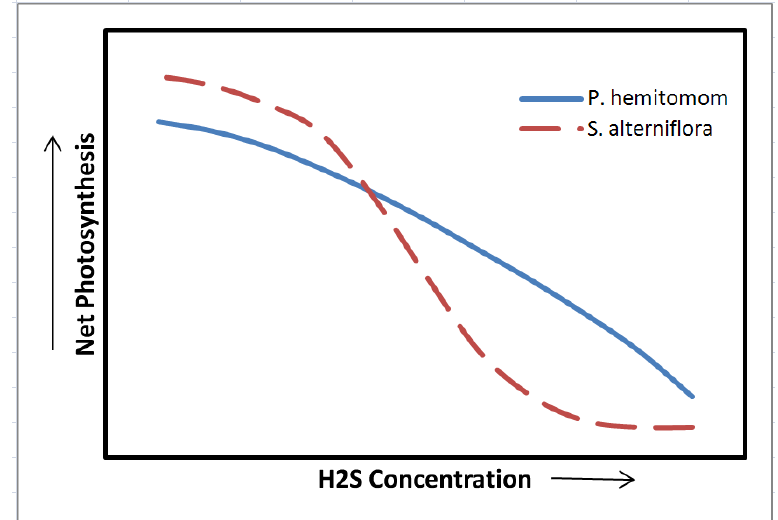
Figure 3. The relationship between net photosynthesis and H sediment for two wetland species, Panicum hemitomom and Spartina alterniflora (from Pezeshki et al .